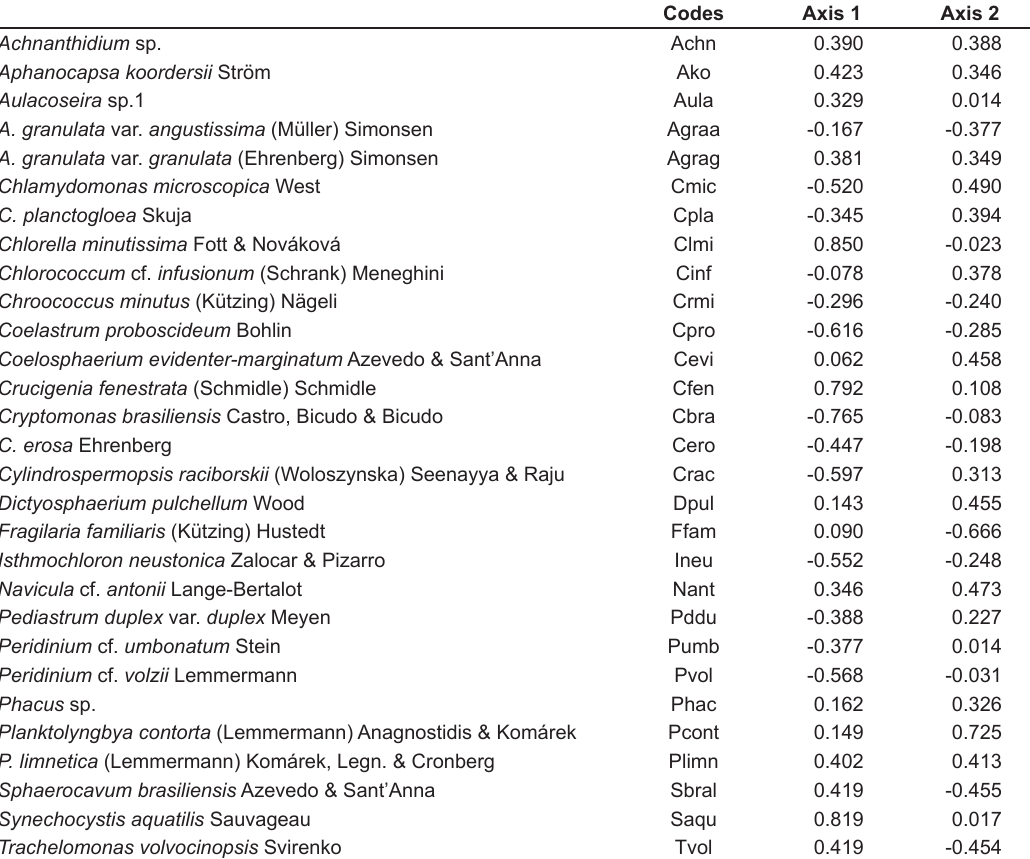
Table 2. Pearson´s correlations obtained for the biovolume of the phytoplankton species and axes 1 and 2 of the